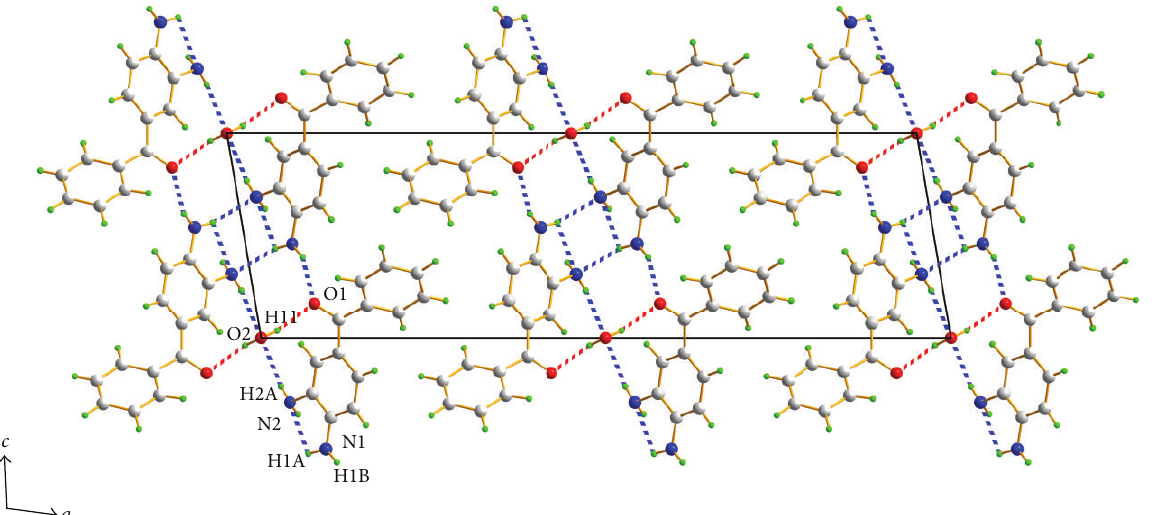
Figure 2: The crystal packing of the title compound, viewed along the b -axis showing the N–H ⋅ ⋅ ⋅ N/O and O–H ⋅⋅⋅ O interaction (dotted